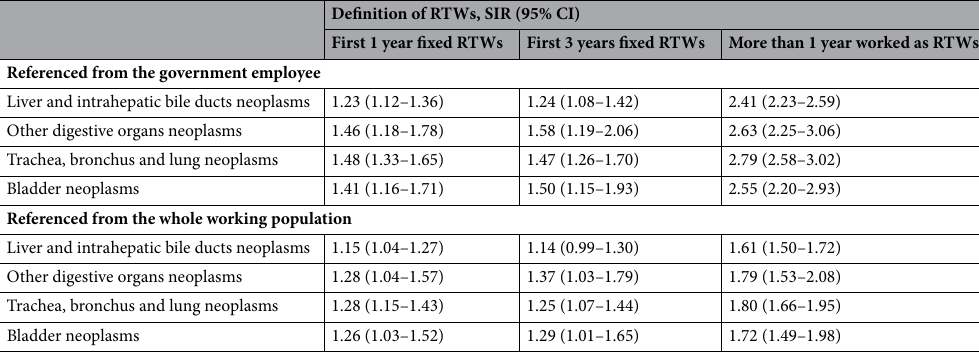
Table 3. Age-standardised incidence ratio (SIR) and 95% confidence interval (CI) of cancers according to the different road transportation workers (RTWs). First 1-year fixed RTWs: RTWs who worked in the road transport industry during the first year (2006) of the study. First 3-year fixed RTWs: RTWs who worked in the road transport industry for the first 3 years (2006–2008) of the study. More than 1 year as RTWs indicated those who worked 1 year or more in the road transport industry during the study (2006–2015). RTW road transportation